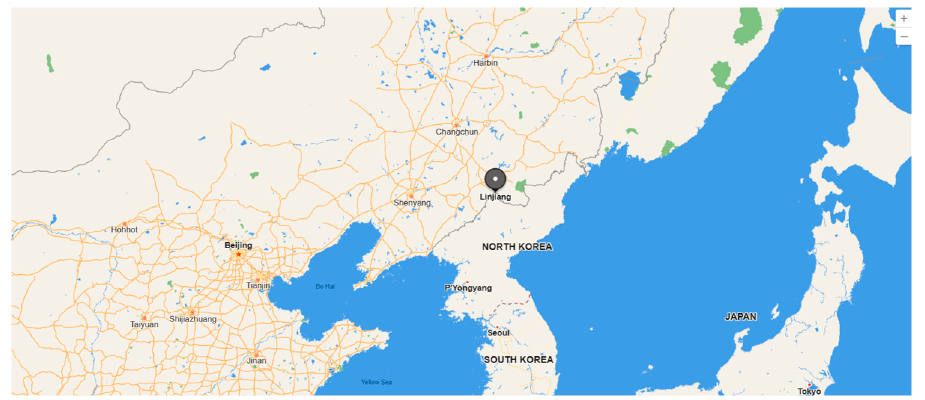
Figure 2. Map of the study plots. Table 1. Pedological characterization and classification of three initial soil samples.